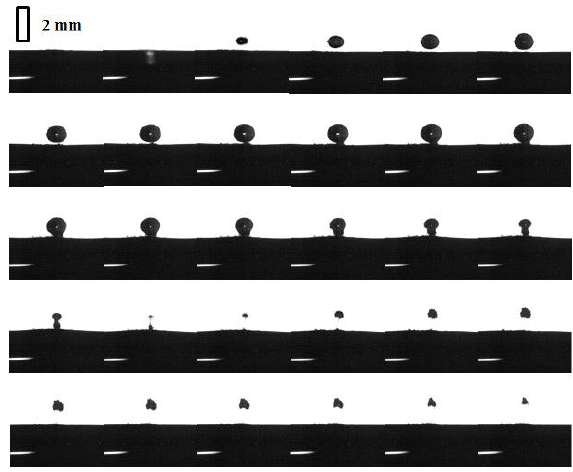
Fig. 5. Bubble dynamics for γ = 1.1. Time between the individual frames is 5.9 µs.